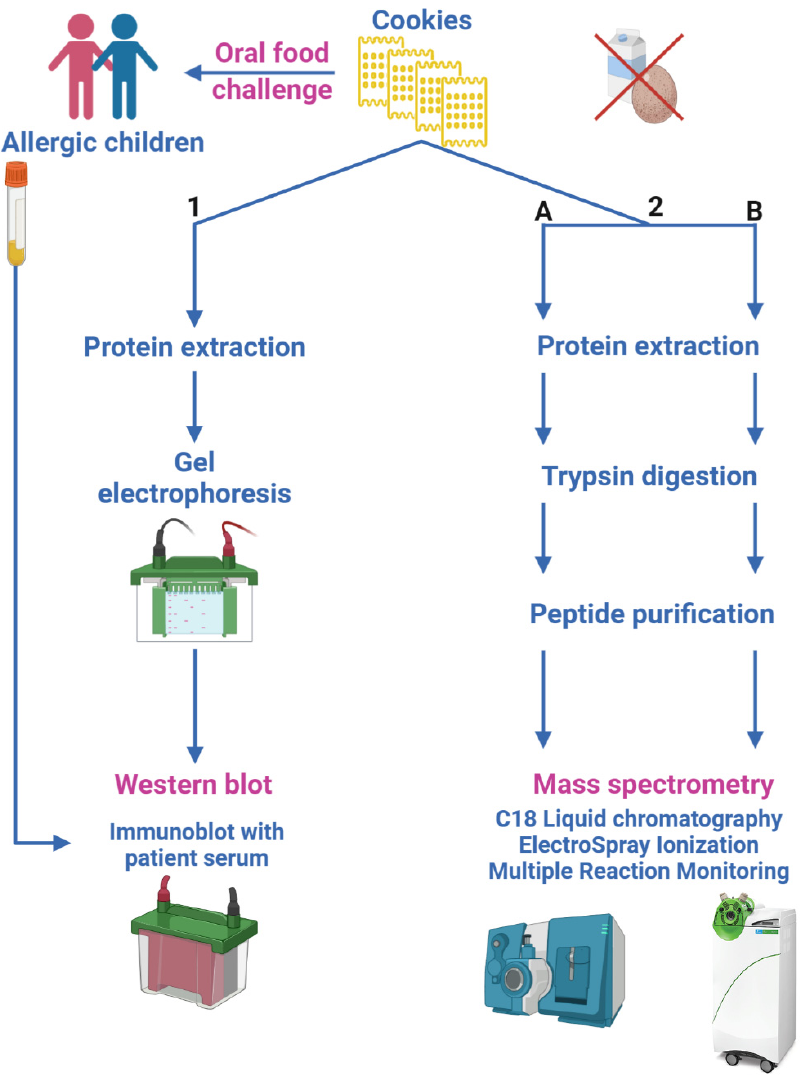
Figure 1. Sketch of the proteomic experimental approaches. (1) Immunoblot experiments determine patient serum binding to egg and milk allergens; (2) LC-ESI-MS/MS analyses, following two different workflows and different Triple Quadrupole MS platforms (2.A and 2.B), quantify egg and milk allergens in biscuits.